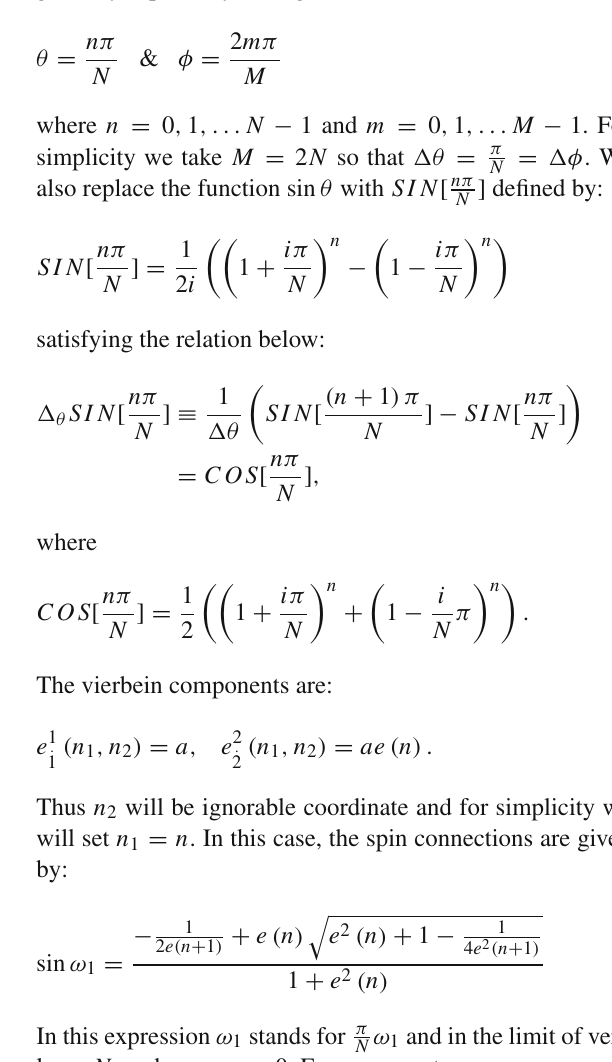
Fig. 4 The calculated Euler characteristic χ is represented by the blue dots, the light green curve is a visual guide, and the dashed line is the expected value